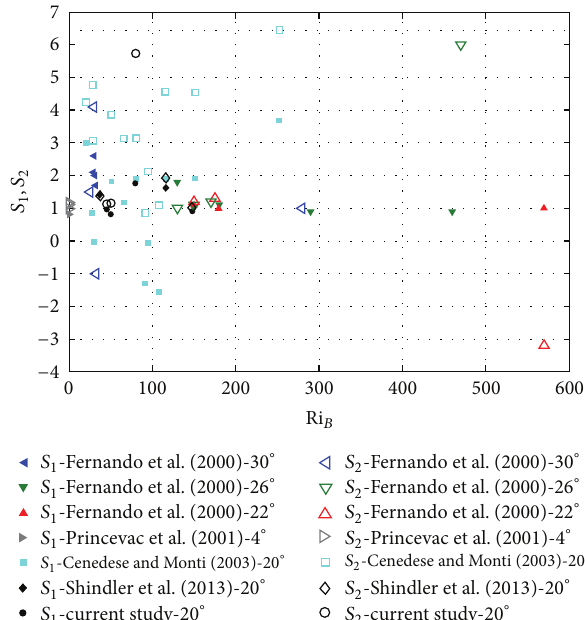
Figure 22: Comparison with Manins and Sawford [6] theoretical